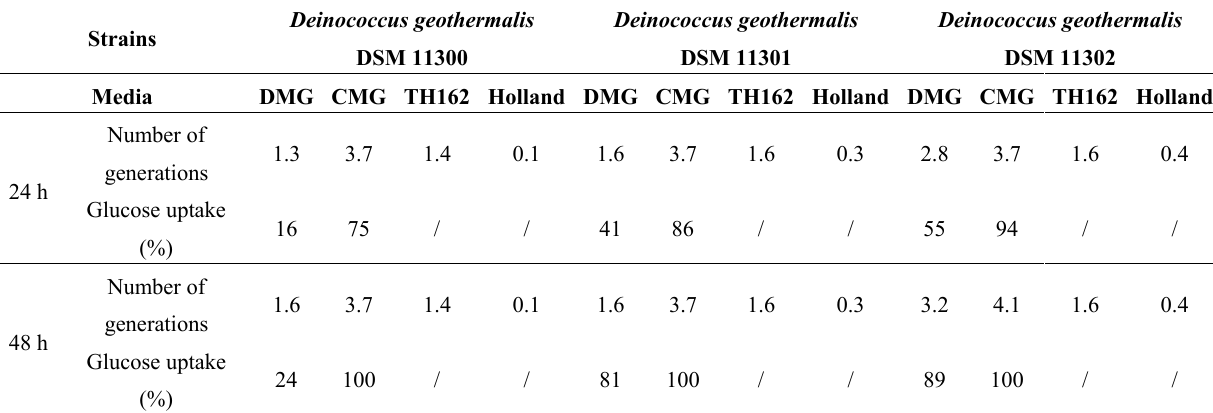
Medium Glucose (CMG), Thermus 162 (TH162) medium and Holland medium. Deinococcus geothermalis Deinococcus geothermalis Deinococcus geothermalis Strains DSM 11300 DSM 11301 DSM